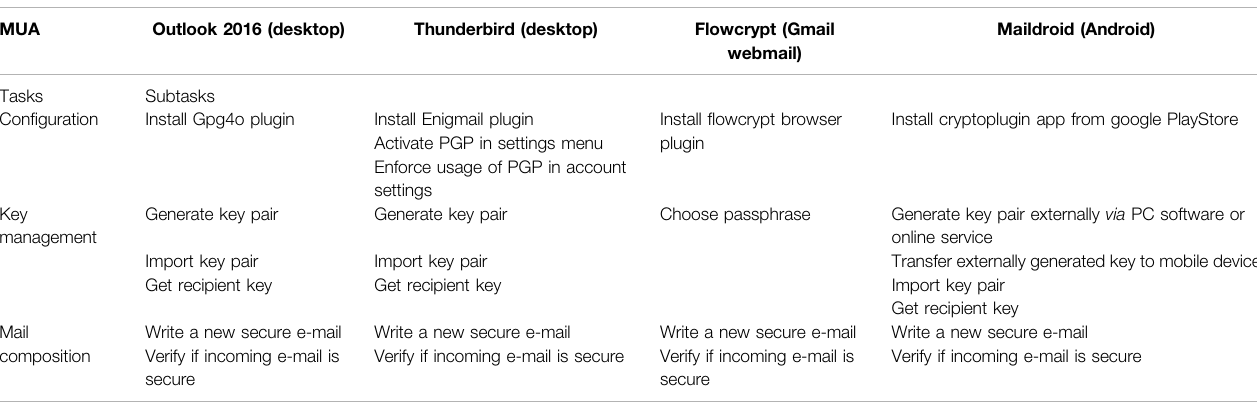
TABLE 5 | Analysis of PGP tasks with four MUAs.